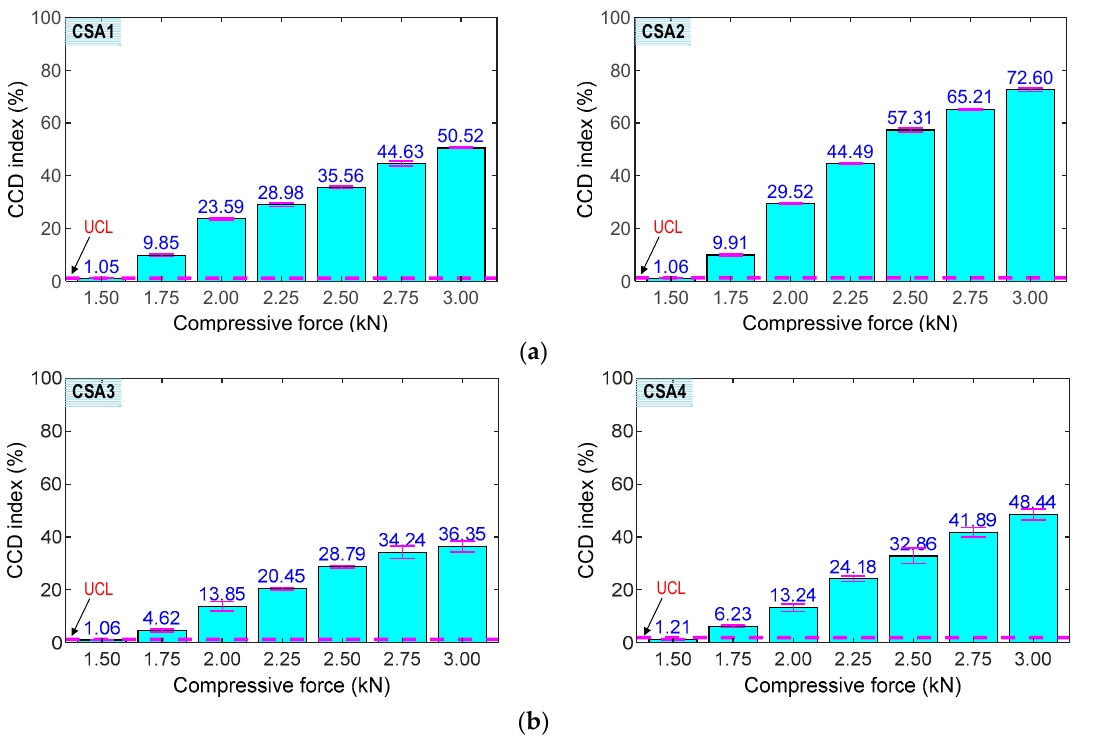
Figure 17. CCD indices of CSAs under compression. ( a ) z-directional loading. ( b ) x-directional loading.